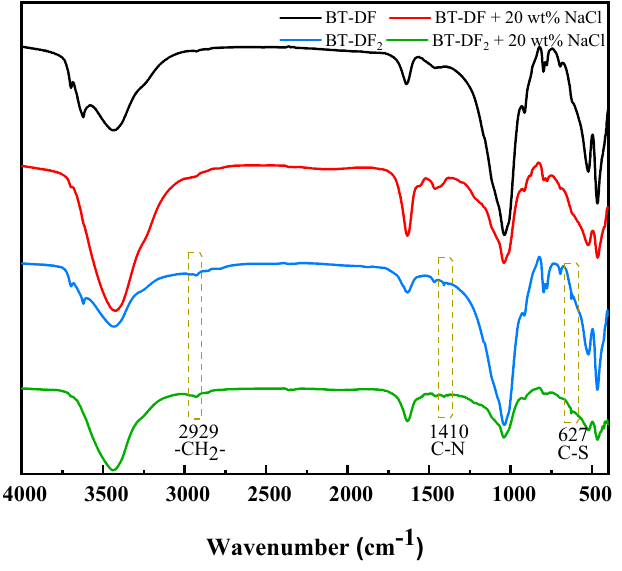
Figure 6. FTIR spectra of BT in different BT-DF (after aging at 200 °C for 16 h).